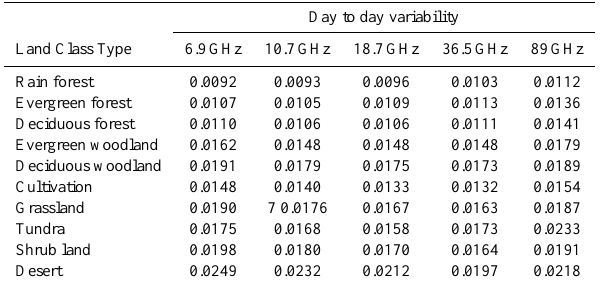
Table 2. Day to day variability of global mean emissivity at vertical polarization for July 2003 at different land vegetation